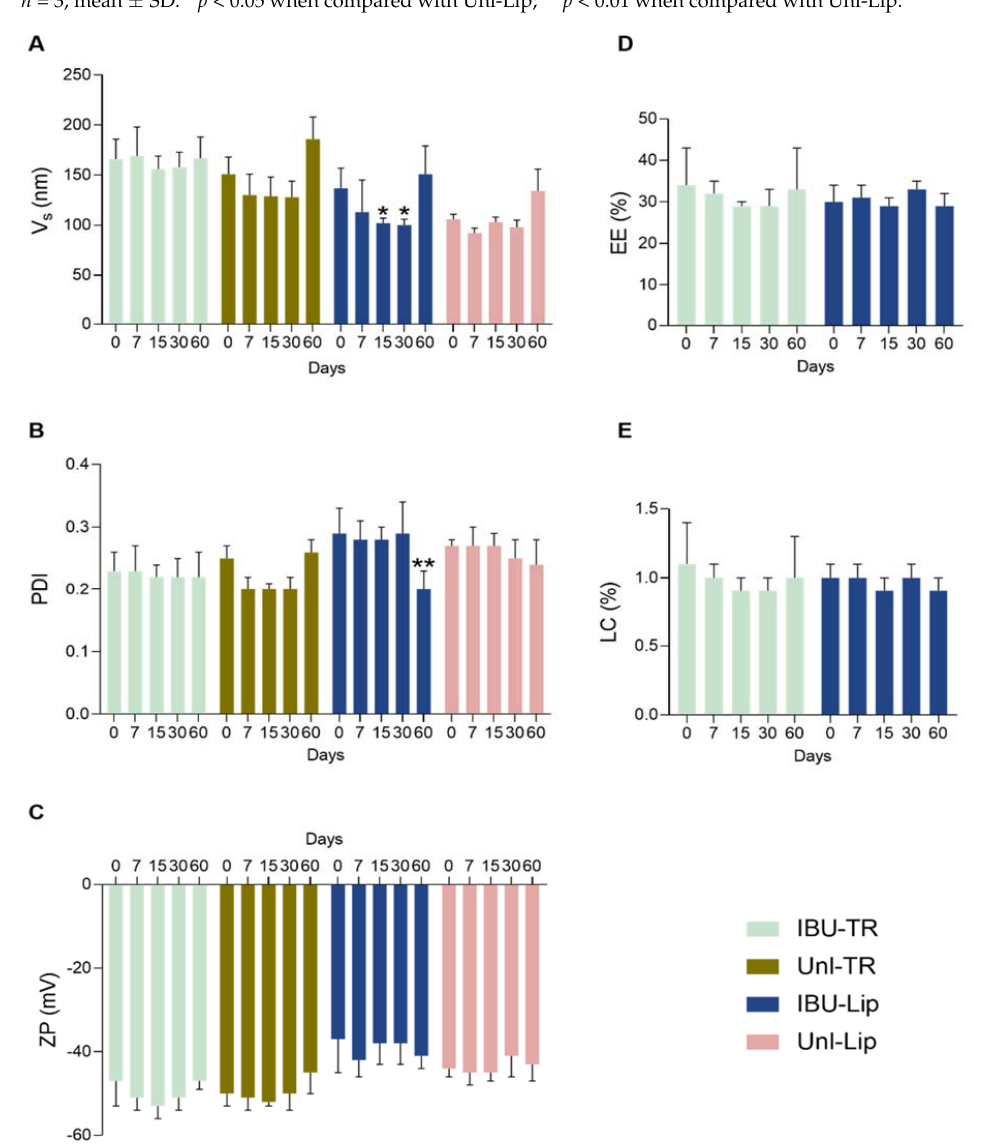
Figure 2. Storage stability under refrigerated conditions (5 ± 3 °C) up to 60 days of unloaded and IBU-loaded transfersomes (Unl-TR and IBU-TR, respectively) and liposomes (Unl-Lip and IBU-Lip, respectively) in terms of the following: ( A ) vesicle size (Vs); ( B ) polydispersity index (PDI); ( C ) zeta potential (ZP); ( D ) encapsulation efficiency (EE); and ( E ) loading capacity (LC). * p < 0.05 and ** p < 0.01 compared with synthesis day—T0 (two-way ANOVA, Bonferroni’s multiple comparison test).